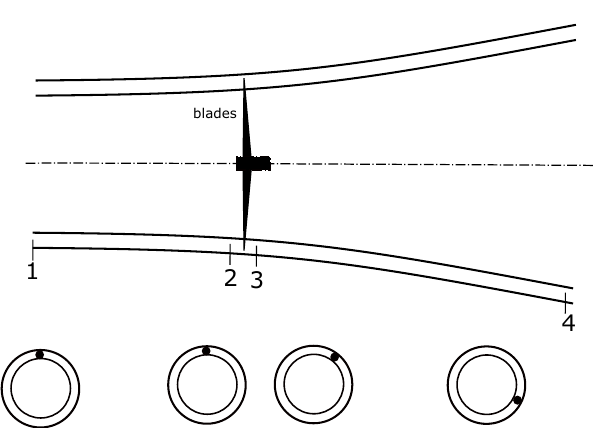
Figure 1. Rotating annular stream tube at various streamwise positions. The illustration is redrawn with modifications based on Ref [7].